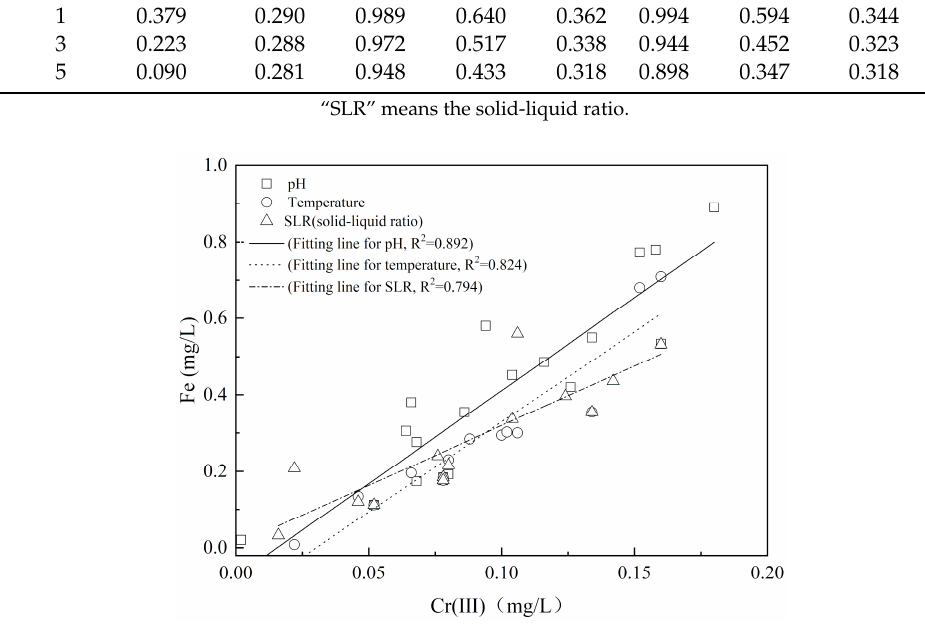
Figure 3. The relationship between dissolved Fe and Cr(III) concentration released into solution under the different leaching conditions.